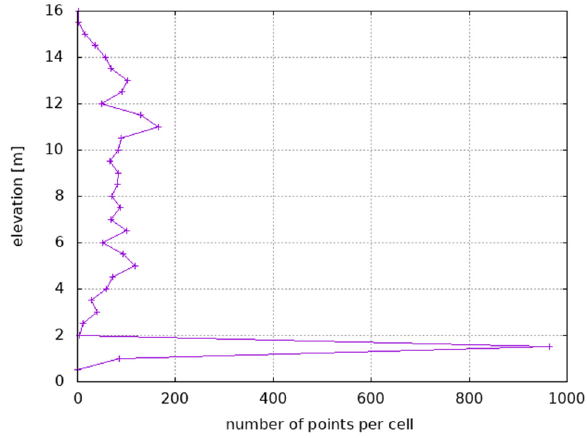
Figure 5. Vertical profile of return pulses in sample area shown in Figure 4 of size 5 m by 5 m.